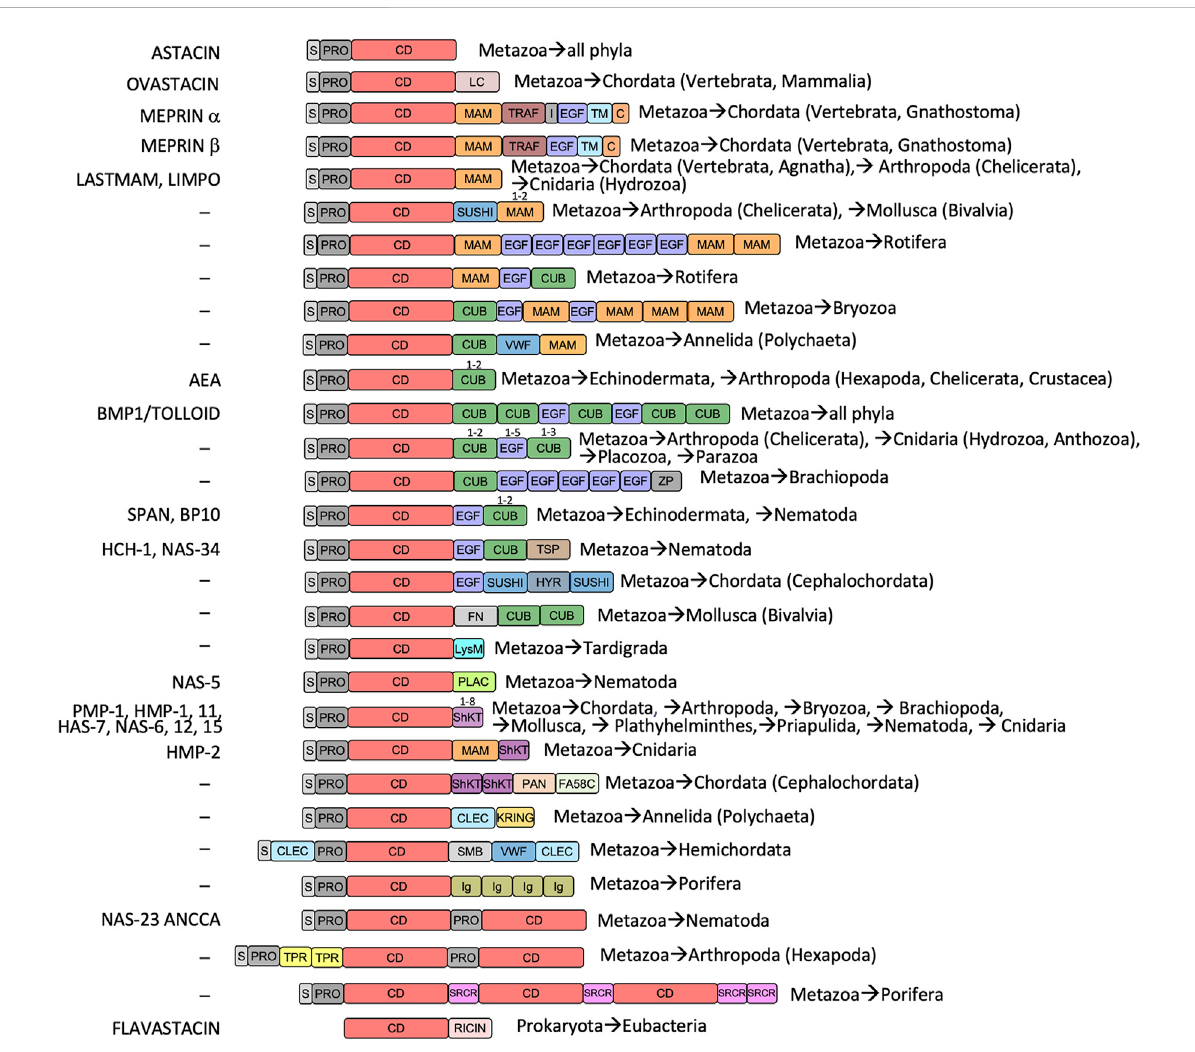
FIGURE 1 Astacin domain combinations and phylogenetic occurrence. Metazoan astacins minimally comprise an N-terminal signal-peptide for extracellular secretion (S), a propeptide or prodomain conferring latency (PRO) and a catalytic zinc-dependent metallopeptidase domain (CD). Moreover, most astacins evince additional domains, listed with Prosite database codes (PS; https://prosite.expasy.org): ABC (ABC-transporter; PS00211), CD (catalytic protease domain; PS51864), C (cytoplasmic tail), CLEC (C-type lectin; PS50041), CUB (found in complement subcomponents C1r/C1s, Uegf and BMP1; PS01180), EGF (epidermal growth factor-like; PS00022), FA58C (factor-5/8 type-C domain; PS500229), FN3 ( fi bronectin type-III domain; PS508539), HYR (hyalin repeat protein; PS50825), I (intervening domain in meprin α , contains a furin cleavage site), IG(immunoglobulin-like;PS508359),KRING(kringle;PS00021),LC(lowcomplexitydomain,disordered),LCCL( Limulus C-domain;PS50820),LYSM (extracellular receptor domain; PS51782), MAM (found in meprin, A5 protein and receptor protein tyrosine phosphatase μ ; PS00740), MATH (meprin andtrafhomologydomain;PS50144),PAN(alsodubbedAPPLE;foundinplasmakallikreinandfactorXI;PS50948),PLAC(polycystin-1,lipoxygenase and α -toxin; PS50095), PTX (pentraxin; PS51828), RICIN (ricin-type lectin; PS50231), SH2 (SARC homology domain; PS50001), ShKT (K + -channel- blocking Stichodactyla helianthus toxin; PS51670), SMB (somatomedin; PS50958), SRCR (cysteine-rich scavenger receptor; PS50287), SUSHI (sushi adhesion domain; PS50923), TPR (tetratricopeptide repeat; PS50005), TSP (thrombospondin-like domain; PS50092), VWF (von-Willebrand-factor domain; PS50234), ZF-UBR (UBR-type zinc- fi nger; PS51157) and ZP2 (zona pellucida protein 2 domain; PS51034). On the left, typical astacin family members are listed, for which physiological functions are documented (see Supplementary Table S1 for complete protein and gene names, and UniProt access codes). Phylogenetic occurrences are indicated on the